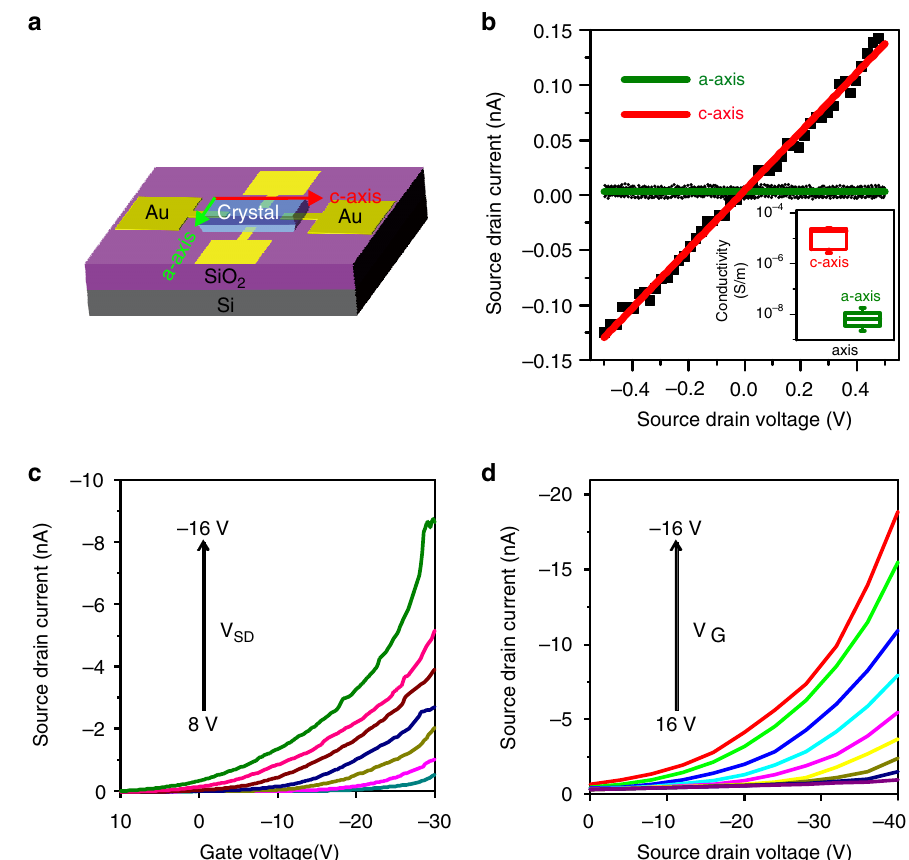
Fig. 8 Electrical transport properties of the cluster polymer crystals. a The structure of the polymer crystal FET. b I – V plot of the polymer crystal along a - axis and c -axis, respectively, with the range of corresponding conductivity values shown in the inset. c Transistor transfer ( V SD = 8 to – 16 V in – 4 V